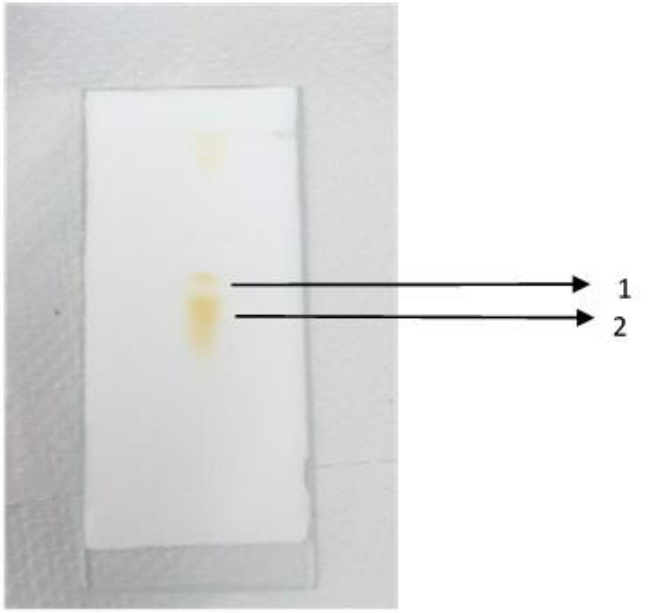
Figure 1. The thin-layer chromatogram of the phospholipids isolated from egg yolk. The two bands indicate phosphatidylethanolamine (band 1) and phosphatidylcholine (band 2), which are the components of phospholipids. The hydrodynamic diameter and zeta potential of liposomes and liposomal- nanoencapsulated